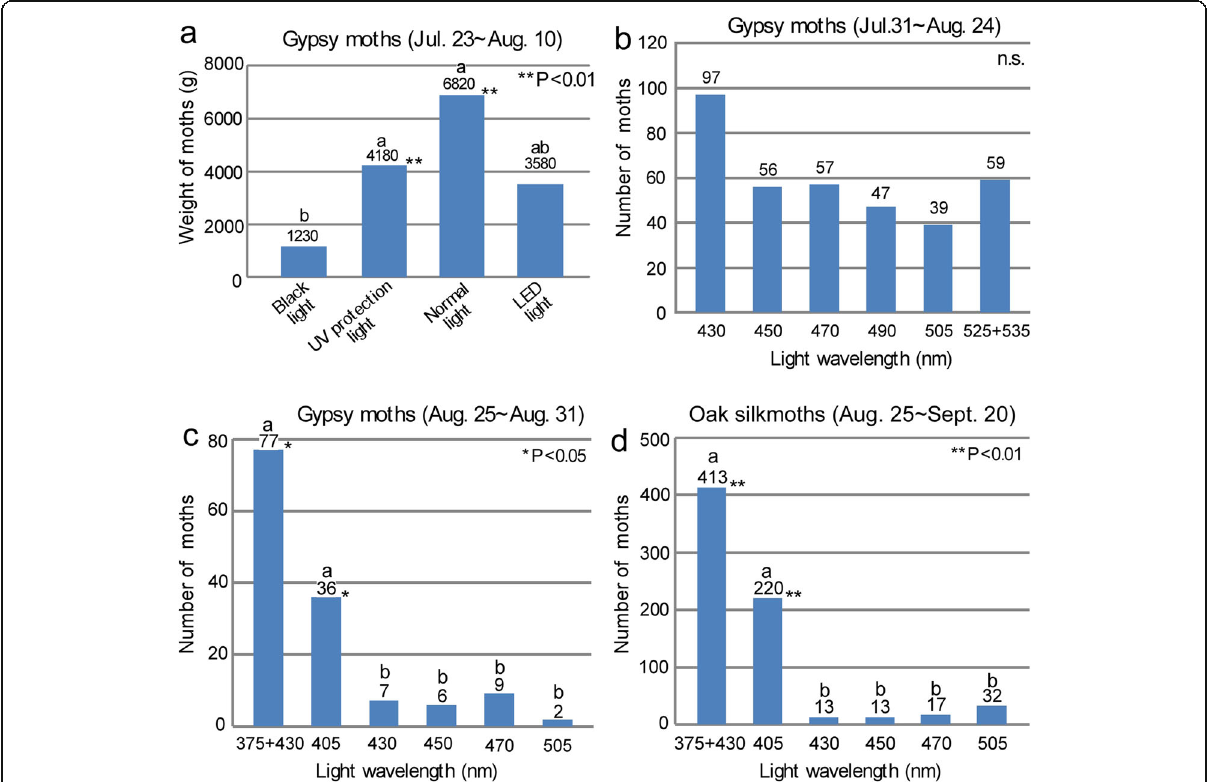
Fig. 5 Effects of light wavelengths on gypsy moth and oak moth attraction. a Attraction of gypsy moths to four “ old-type ” fluorescent lights with UV light emission (< 380 nm) eliminated. b , c Attraction of gypsy moths before ( b ) and after the introduction of a UV LED to an array of LEDs with visible-light wavelengths ( c ). d Attraction of Japanese oak silkmoths to UV and visible-light LEDs. The results shown in ( a ) were from experiments at the Mt. Usu rest area in the last year (2014) of the gypsy moth outbreak, and the results shown in ( b - d ) were from experiments in Yubari in 2018. Means not sharing the same letter are significantly different (Steel-Dwass test, * P < 0.05, ** P <